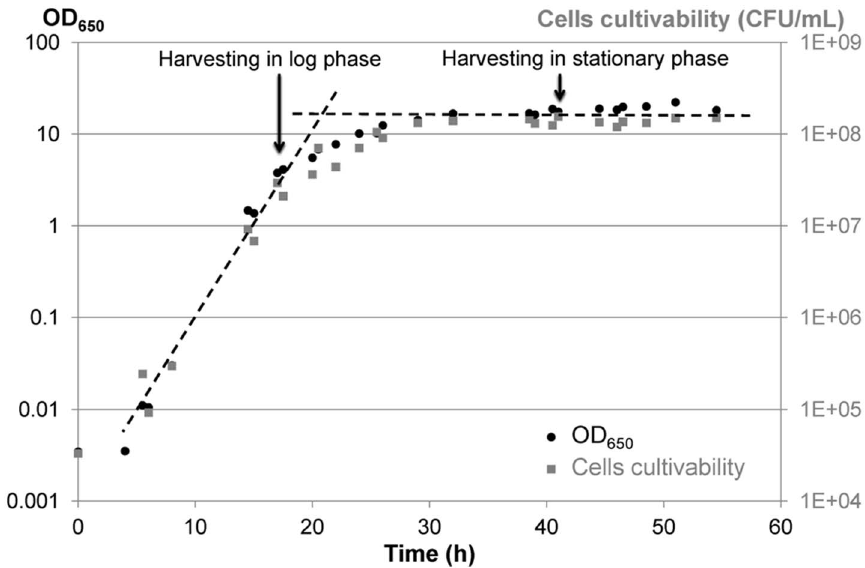
Figure 1. Growth curves of Yarrowialipolytica at 28 6 C in YPD and indication of harvesting times. Growth curves were followed by DO 650 (black dots) and cell cultivability (gray boxes, CFU/mL).